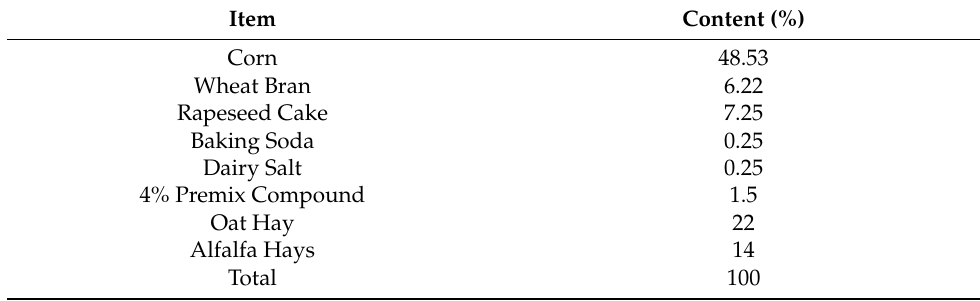
Table 1. Basic Diet Composition of Group